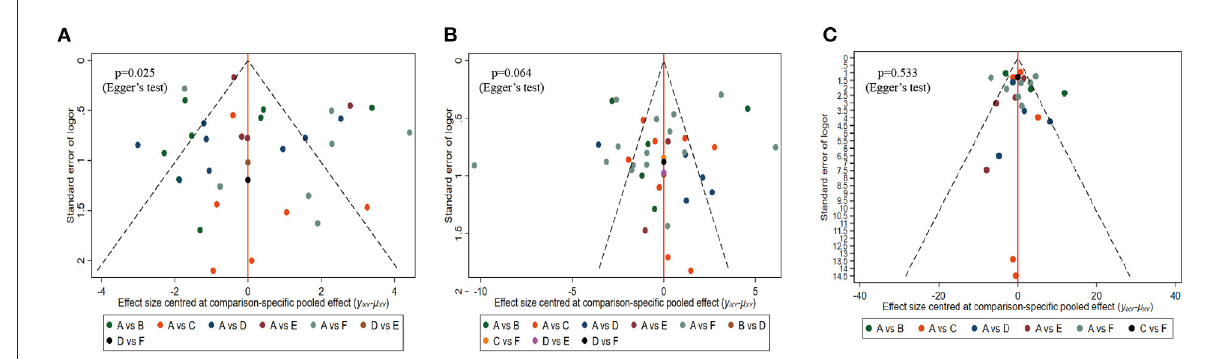
FIGURE6 Comparison-adjusted funnel plots. (A) MOCA, (B) MMSE, (C) BI. Labels: A, NOR(Normal rehabilitation); B, TMS (Transcranial Direct Current Stimulation); C, VR (Virtual Reality Exposure Therapy); D, CA (Computer-assisted cognitive rehabilitation); E, tDCS (Transcranial Direct Current Stimulation); F,